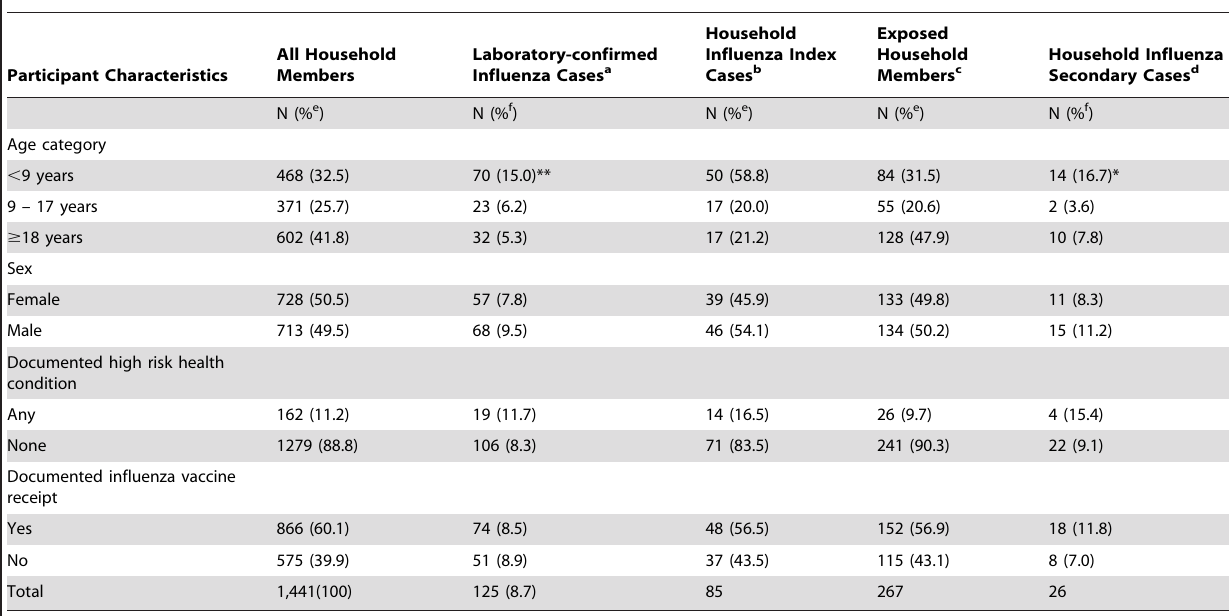
Table 1. Characteristics of all household members, those with laboratory-confirmed influenza a , household index cases b , exposed household members c and secondary cases d : the Household Influenza Vaccine Effectiveness (HIVE) study, Ann Arbor Michigan, 2010-2011 influenza